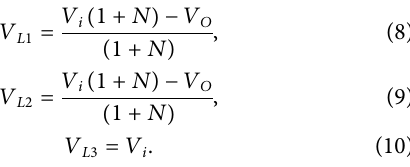
Mode 3: as shown in Figure 3C , the switch S 3 is initially turned on, while the switches S 1 and S 2 are turned off. Current from the battery fl ows through the winding L 3 and switch S 3 . The battery current also conducts L 1 and L 2 . Current fl ows through L 1 to D 1 , L C1 , L C2 , D 6 , C, and the load. Current fl ows through L 2 to D 2 , L C2 , D 6 , C, and the load.